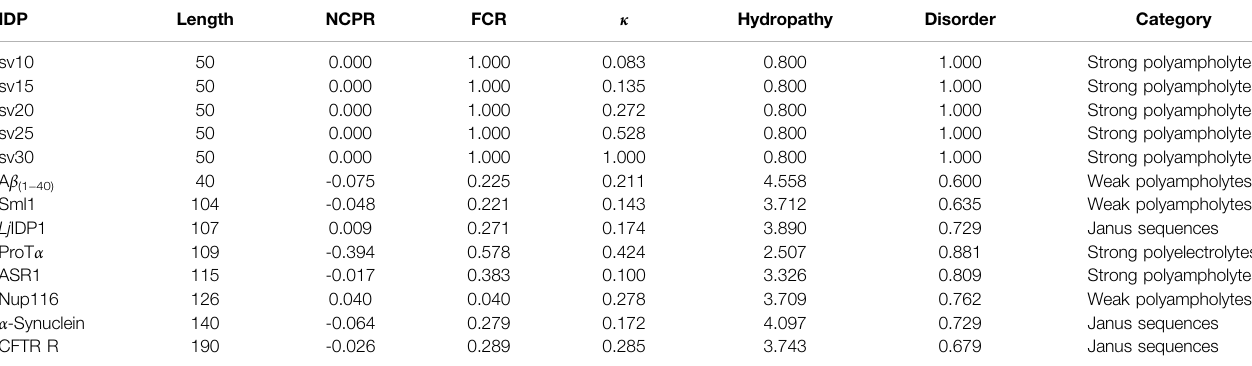
TABLE 1 | Summary of classi fi cation of intrinsically disordered ensemble regions (CIDER) (Holehouse et al., 2015) results for the IDPs used in the study. NCPR denotes the net charge per residue, FCR denotes the fraction of charged residues, and κ denotes the measure of charge segregation from Das and Pappu (2013). Hydrophathy measures how hydrophobic the sequence is (0 – 9 with 0 being least hydrophobic and nine being most hydrophobic) (Kyte and Doolittle, 1982) and disorder measures the fraction of disorder promoting residues (Uversky, 2002). The categorization of each IDP is determined from the Das-Pappu phase diagram (Das and Pappu, 2013; Holehouse et al.,